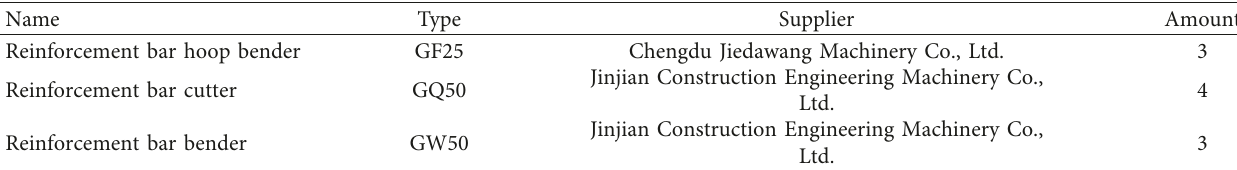
Table 7: Equipment information for reinforced bar skeleton